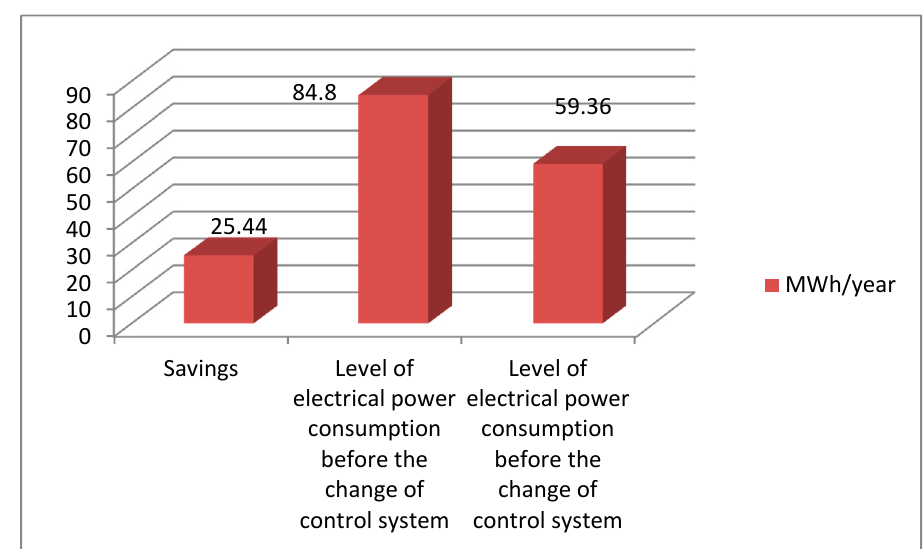
Figure 14. Results of energy optimization of the internal recirculation process.